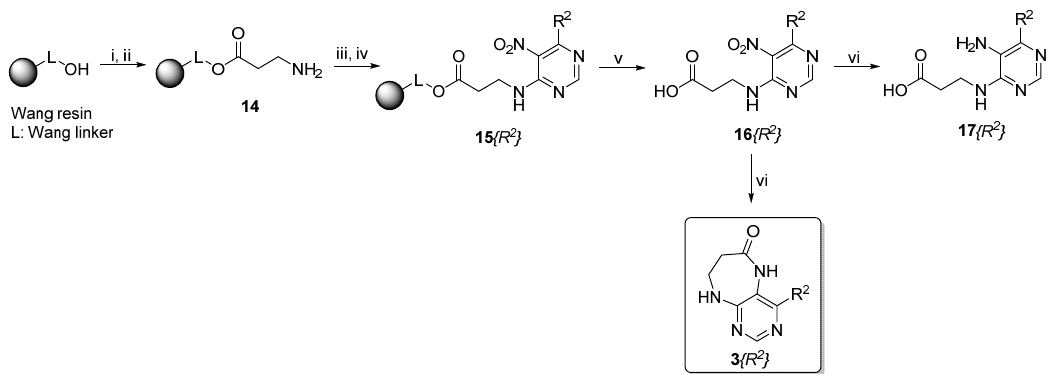
Molecules 2021 , 26 , x FOR PEER REVIEW Table 3. Summary of reaction conditions for cyclization leading to pyrimidodiazepinones 3 .